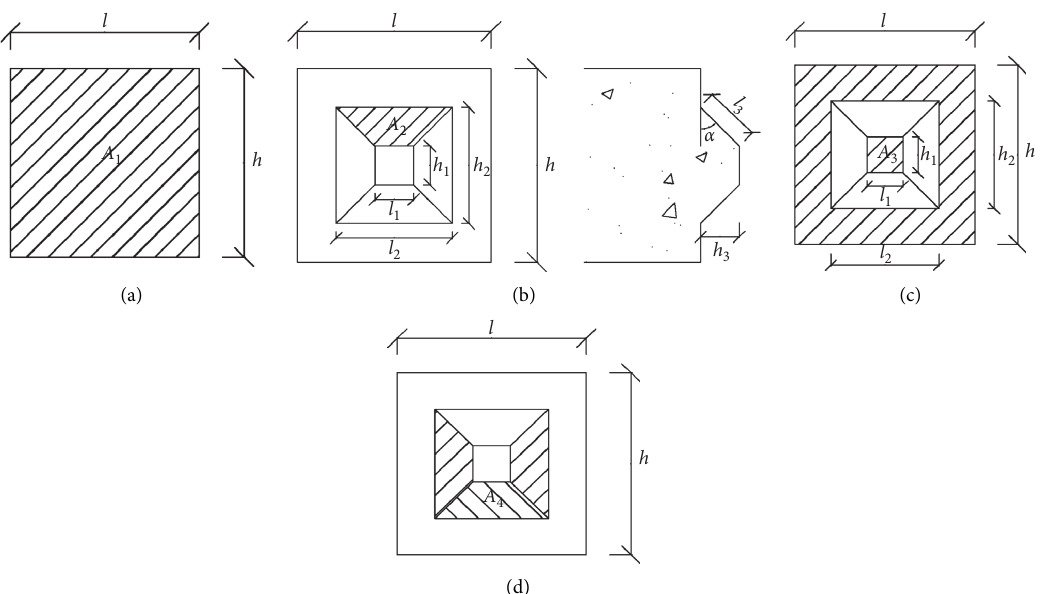
Figure 14: Detailed configurations of three specimens. (a) Configuration of Type 2. (b) Configuration of Type 1 and Type 3. (c) The area A (d) The area A 4